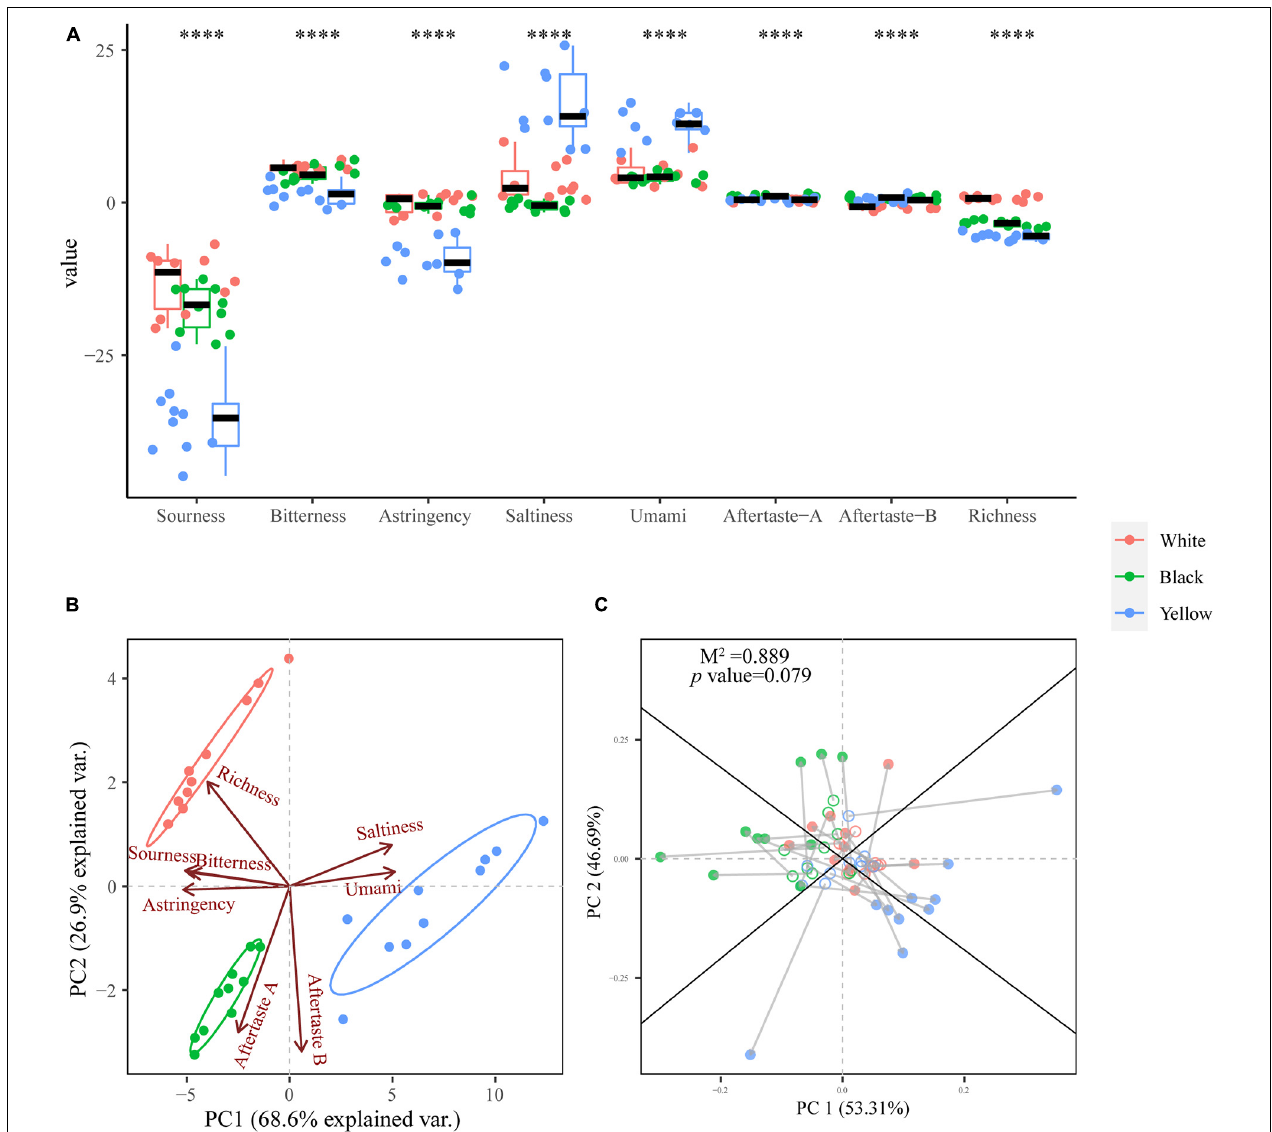
FIGURE 5 | Box plot for taste profiles of the three types of HTD samples (A) . Significant difference is represented by ∗∗∗∗ ( p < 0.0001). PCA biplot based on the taste profiles of HTD samples (B) . Procrustes analysis of the correlation between dominate fungal genera and aroma profiles ( M 2 = 0.889, p = 0.079, 999 permutations) (C)